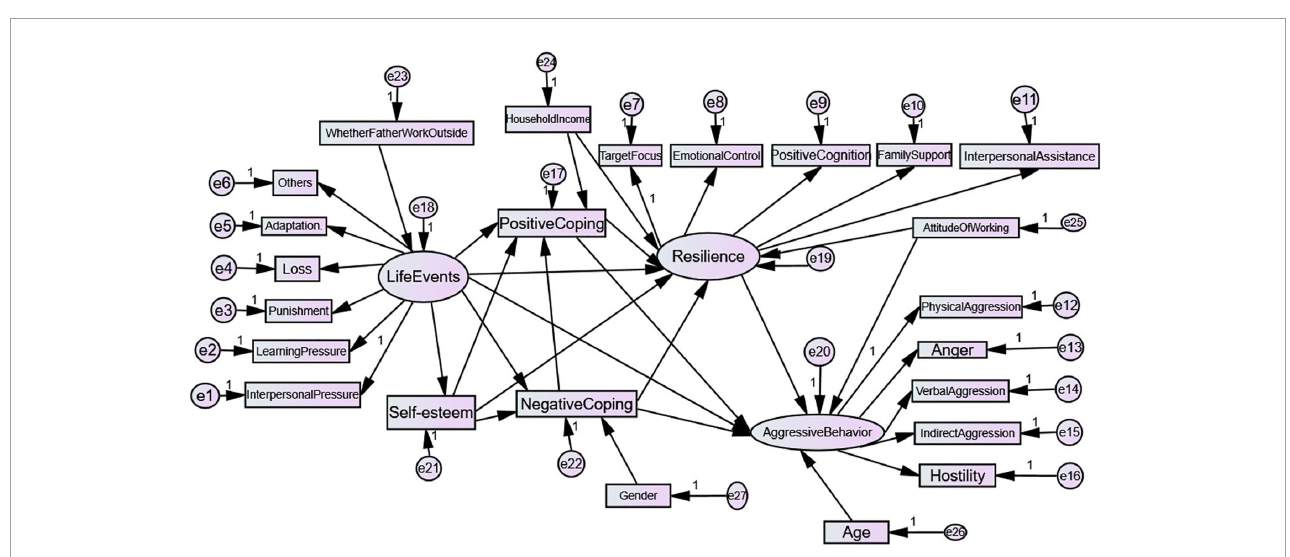
FIGURE2 Hypothetical model